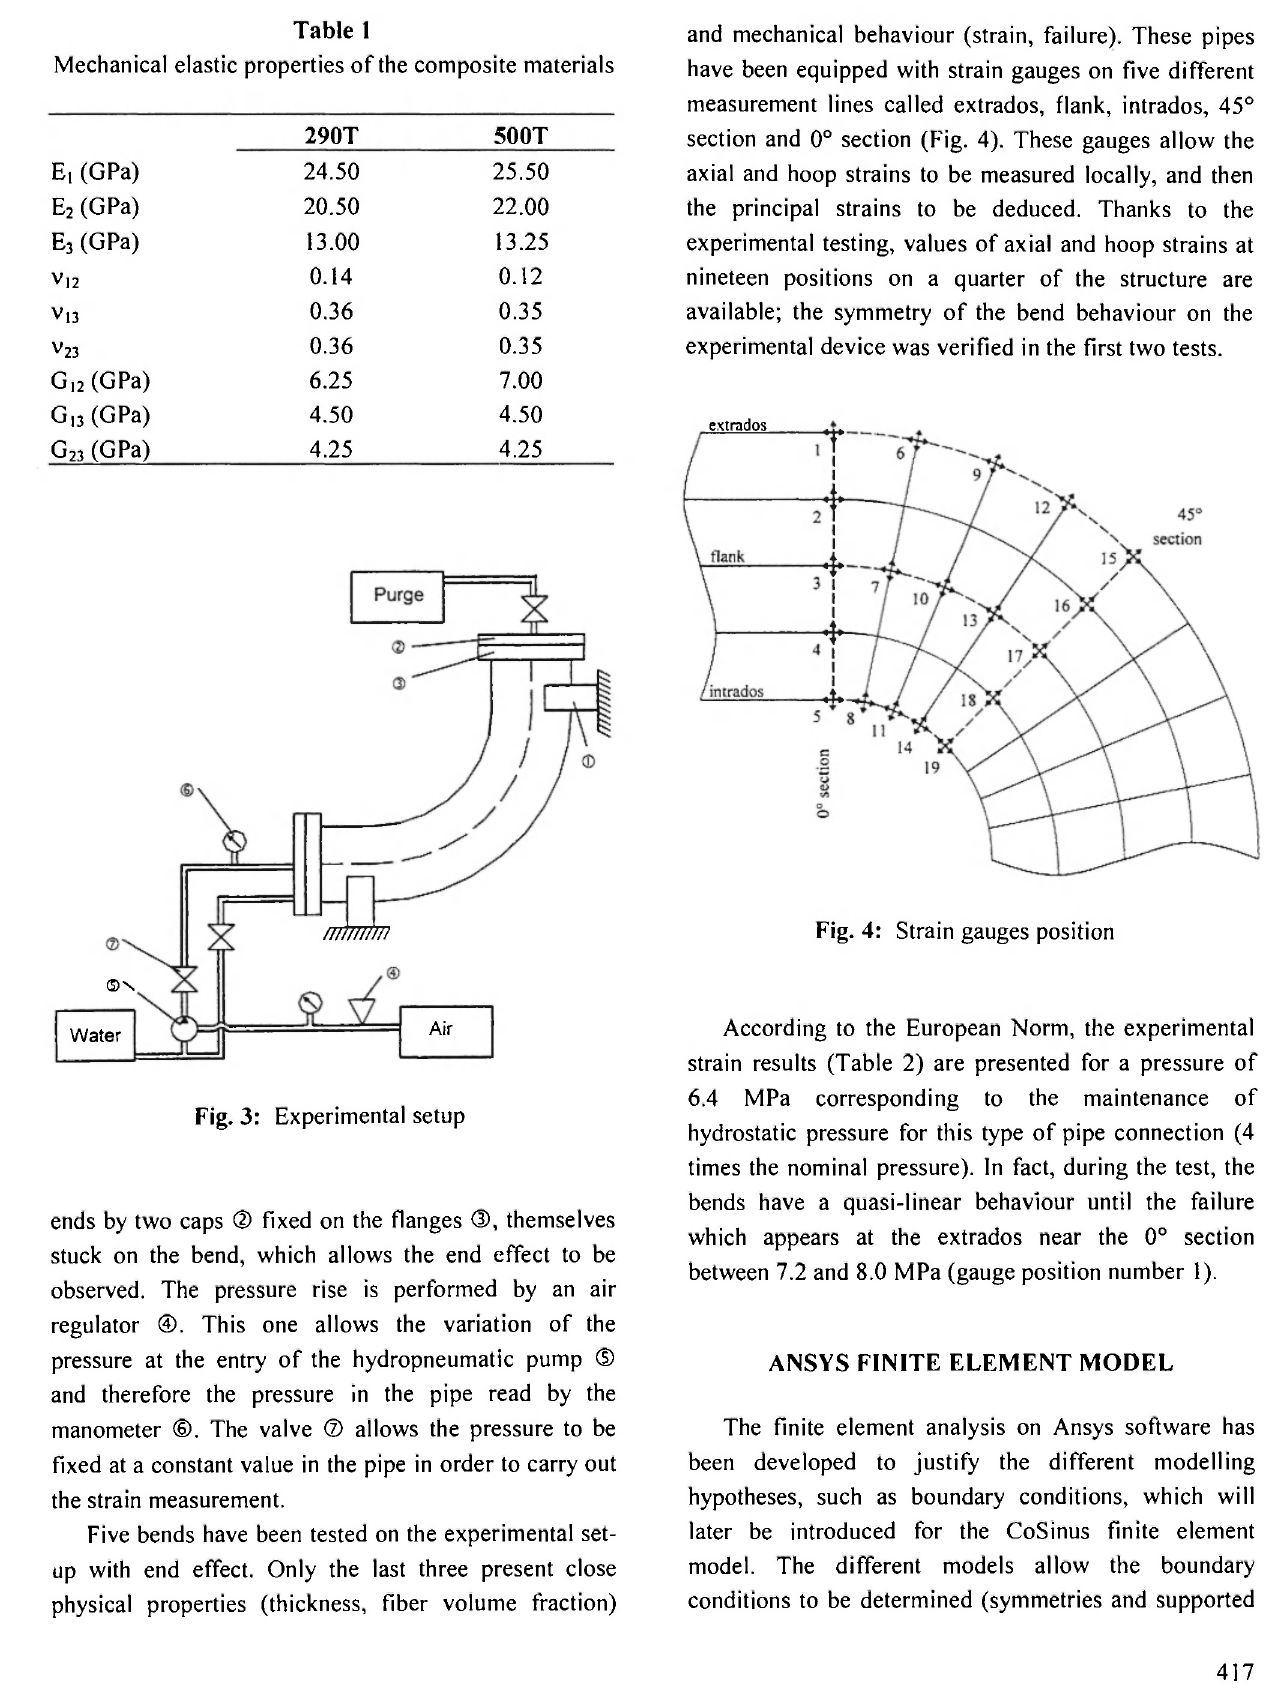
Fig. 4: Strain gauges